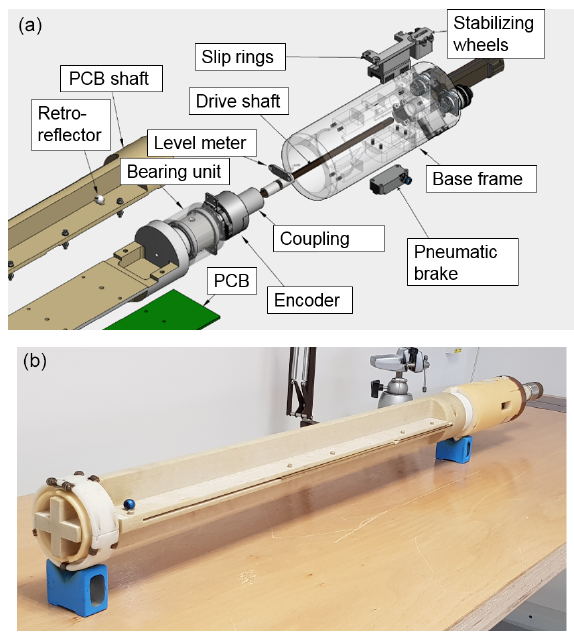
Figure 3. First prototype measurement system. (a) View of the probe base structure. (b) The assembled